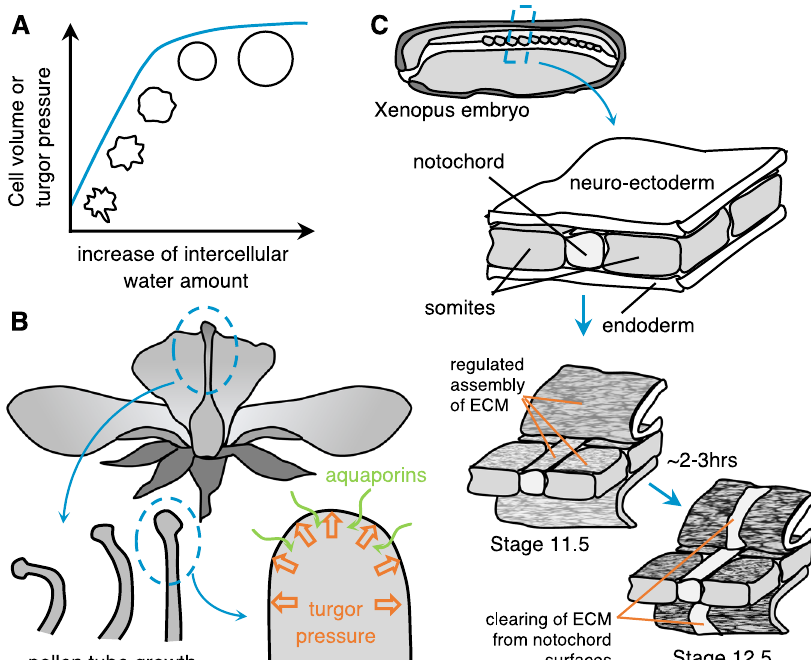
Fig. 7 Changes to tissue stiffness resulting from changes in cellular composition and extracellular environments. A , B Amount of water present in plant cells, builds up the turgor pressure ( A ), and drives local morphogenesis and overall integrity and rigidity of the tissue, such as the growth of the pollen tube in fl owers ( B , adapted from ref. 80 with permission from the Annals of Botany ). C ECM components such as fi bronectin fi brils delimit tissue boundaries, such as between neural/mesoderm interface in developing Xenopus embryos (adapted from ref. 87 with permission from Developmental Dynamics